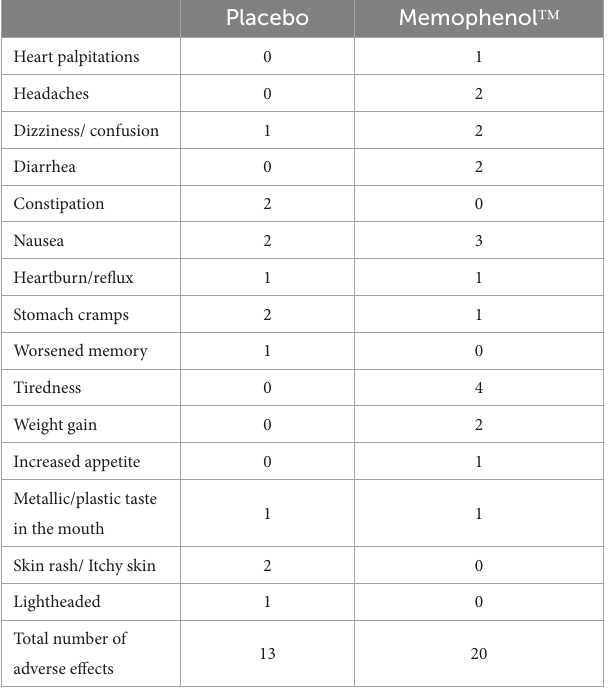
TABLE 5 Frequency of self-reported adverse events.